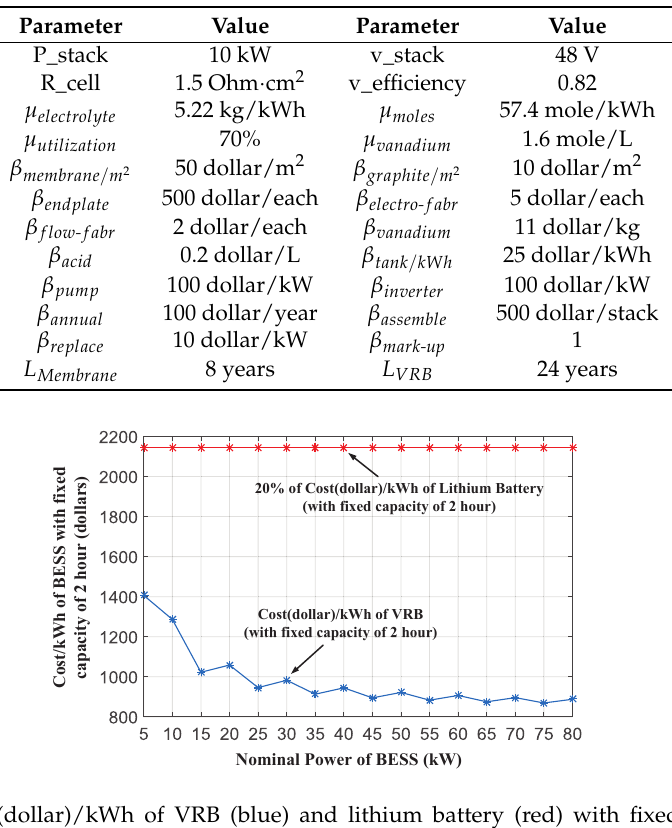
Figure 2. Cost(dollar)/kWh of VRB (blue) and lithium battery (red) with fixed capacity (2 h), but varying nominal power.